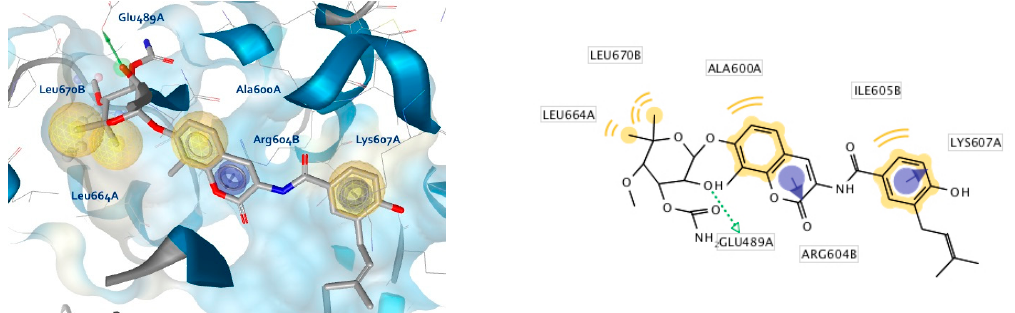
Figure 13. Interactions of novobiocin with the Hsp90 CTD binding site from the MD simulation used to derive the SB-model for virtual screening. The pharmacophore features are as follows: hydrophobics (yellow spheres), aromatics (blue discs), hydrogen bond donor (green arrow), positive ionizable (blue stars).